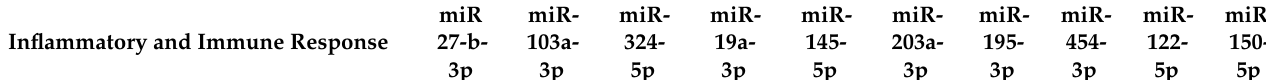
Table 3. Identification of microRNAs regulating genes expressing proteins differentially represented in the proteomic profile of the LS- G6pc − / −